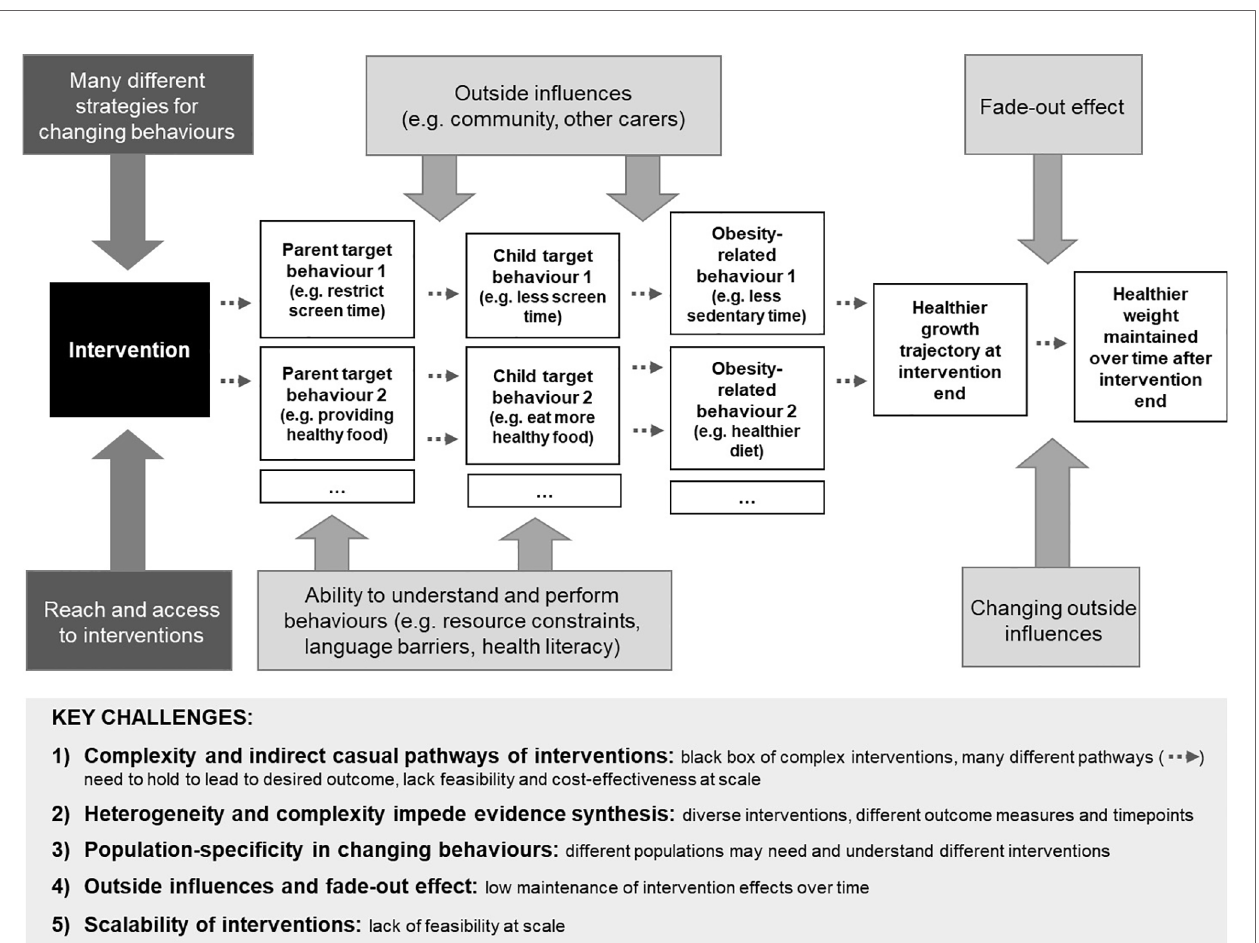
FIGURE 1 | Simpli fi ed illustration of intervention pathways and challenges for effective childhood obesity prevention. The ‘ Key challenges ’ box at the bottom of the fi gure summarises the challenges arising from the complex pathway depicted in the top section of the fi